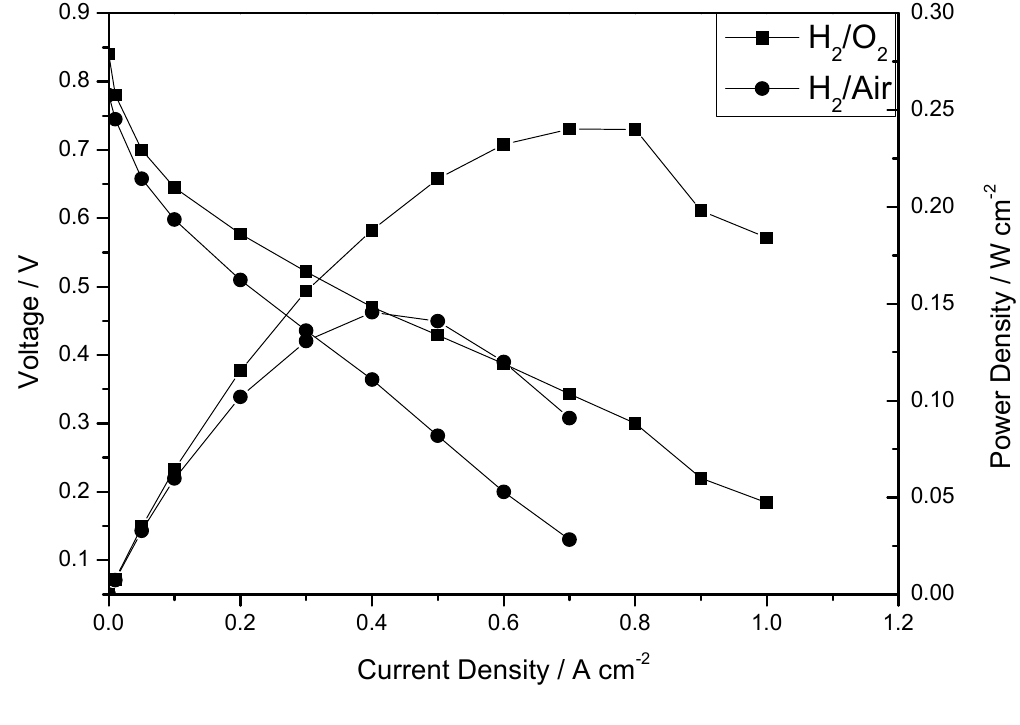
Figure 5. Polarization and power density curves of a fuel cell operated at 150 °C with /O ; and ( b ) H /air atmospheric pressure. Pt loading: cathode 0.4 mg cm − 2 ; anode ( a ) H 2 2 2 0.2 mg cm − 2 ; no gas humidity, H PO PRU: 1.8, membrane thickness 28 μ m. Gas rate: 3 4 anode: 40 dm 3 min − 1 ; cathode: 70 dm 3 min − 1